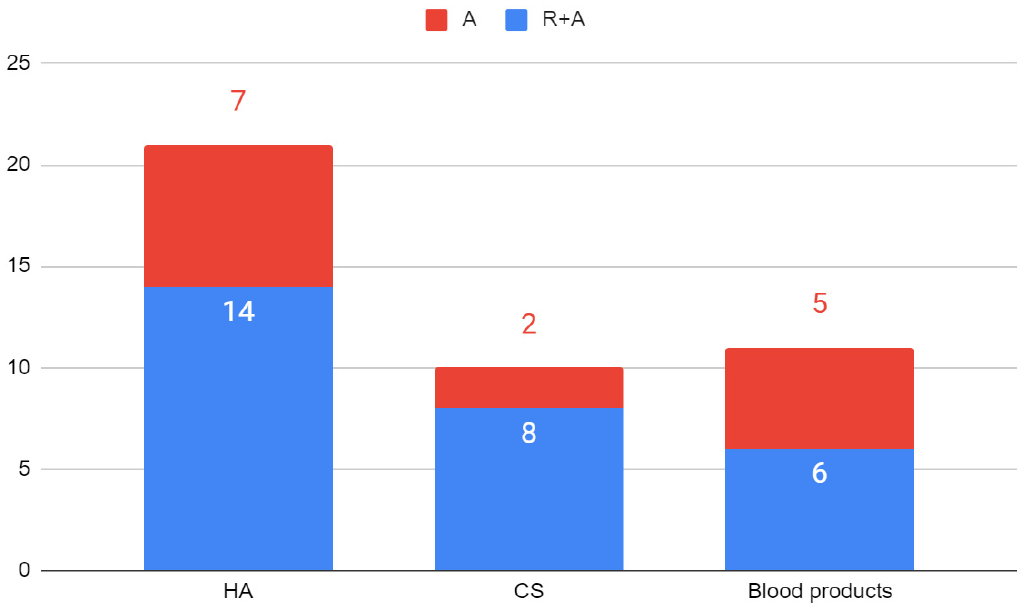
Figure 3. Number of studies with and without prior arthrocentesis (three most popular substances): A—administration; R—rinse; HA—hyaluronic acid; CS—corticosteroids.